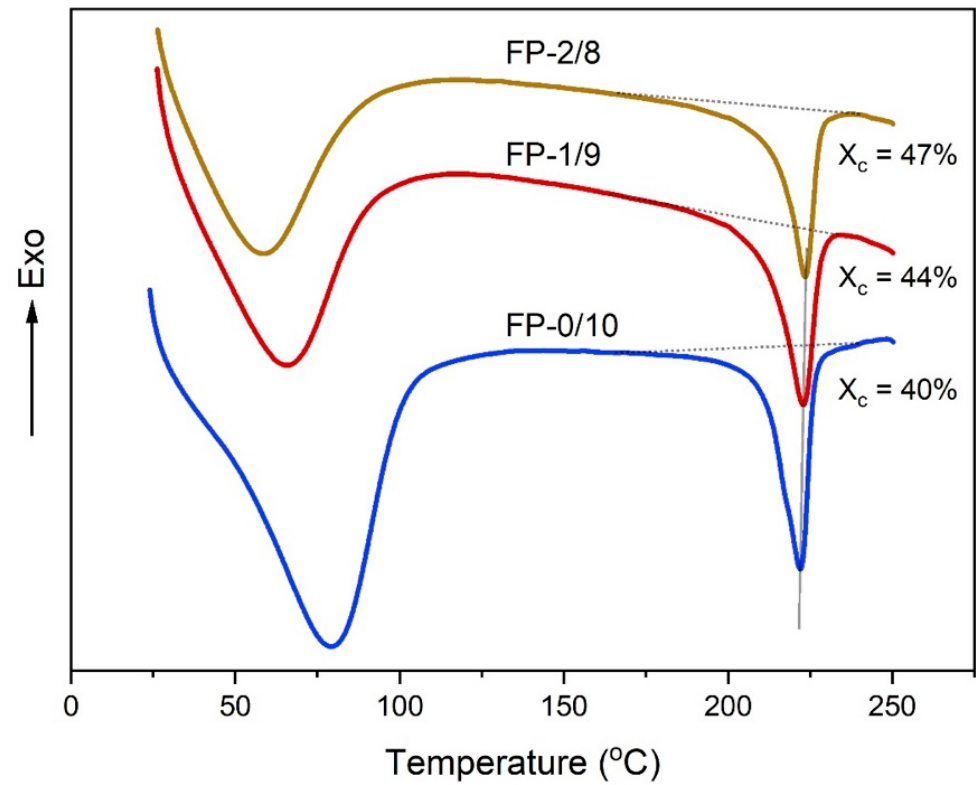
Figure 5. DSC curves of PVA and FNFs/PVA composite nanofibers. The TG and DTG curves of PVA, FNFs, and their nanofiber composites are shown in Figure 6. The weight losses for PVA occurred at 210 ◦ C and 400 ◦ C, caused by the decomposition of the side chain and the main chains of PVA [31]. The pyrolysis temperature of the composite nanofibers was increased with the addition of FNFs. In the plot of DTG, FP-1/9 has two peaks at 240 ◦ C and 350 ◦ C due to the decomposition of PVA. However, these two peaks merged together when the FNFs increased to 20 wt% and shifted to a temperature even higher than that of FNFs. It is considered to be the fibrillar networks of FNFs in PVA matrix and hydrogen bonding between PVA and FNFs without any phase separation. Previous studies have reported that hydrogen bonding interactions plays an important role in improving polymer composites by promoting the miscibility of polymer blends [32]. Additionally, the increased crystallinity of PVA with the addition of FNFs made the molecular chains of PVA more rigid and pushed the DTG peak to a higher